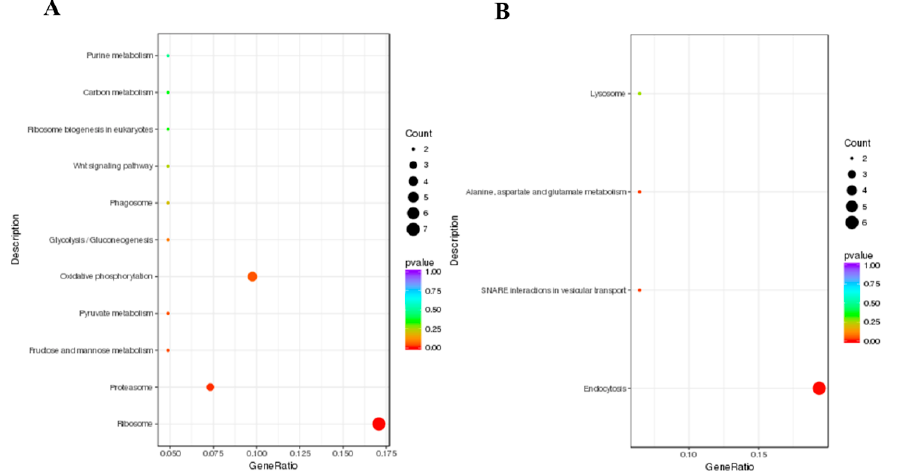
Figure 4. KEGG (Kyoto Encyclopedia of Genes and Genomes) enrichment analysis of DEGs. A scatter diagram of KEGG pathways. The X -axis indicates the gene ratio. The Y -axis indicates different pathways. ( A ) Upregulated DEGs. ( B ) Downregulated DEGs.